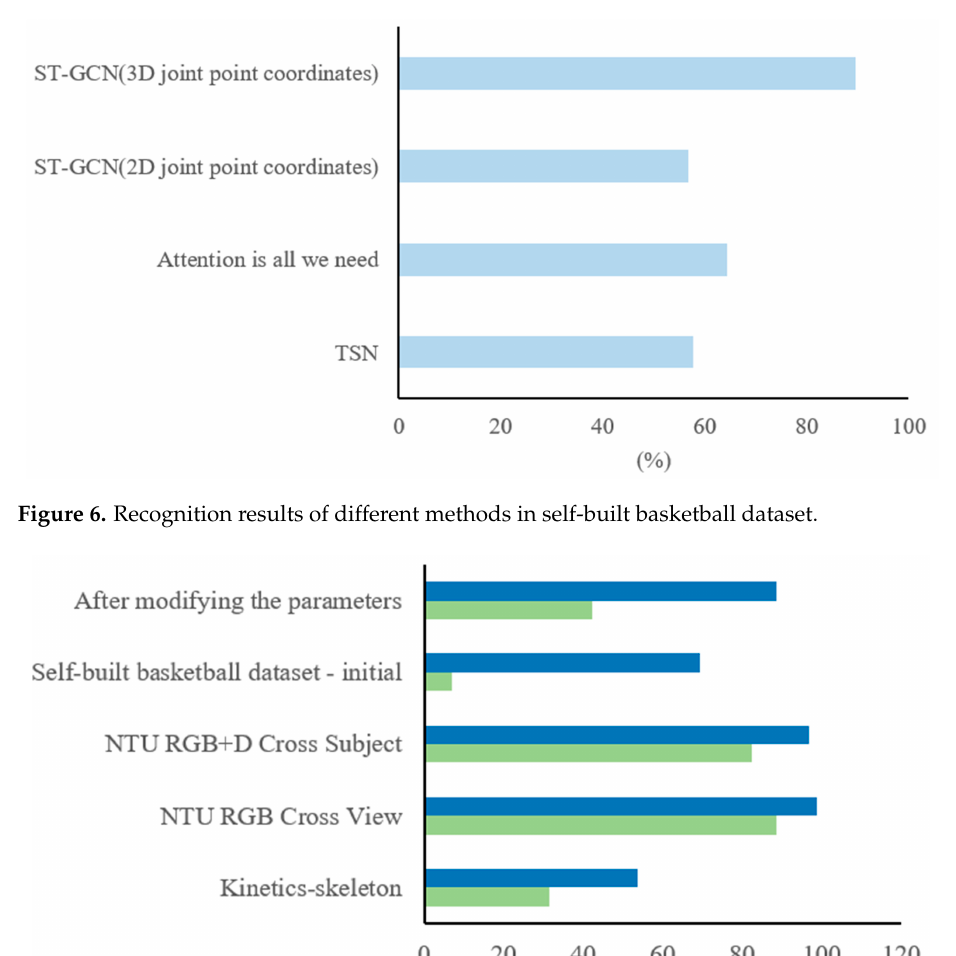
12 of 23 Table 4. Comparison of 3D-based recognition methods in NTURGB-D. ST-LSTM